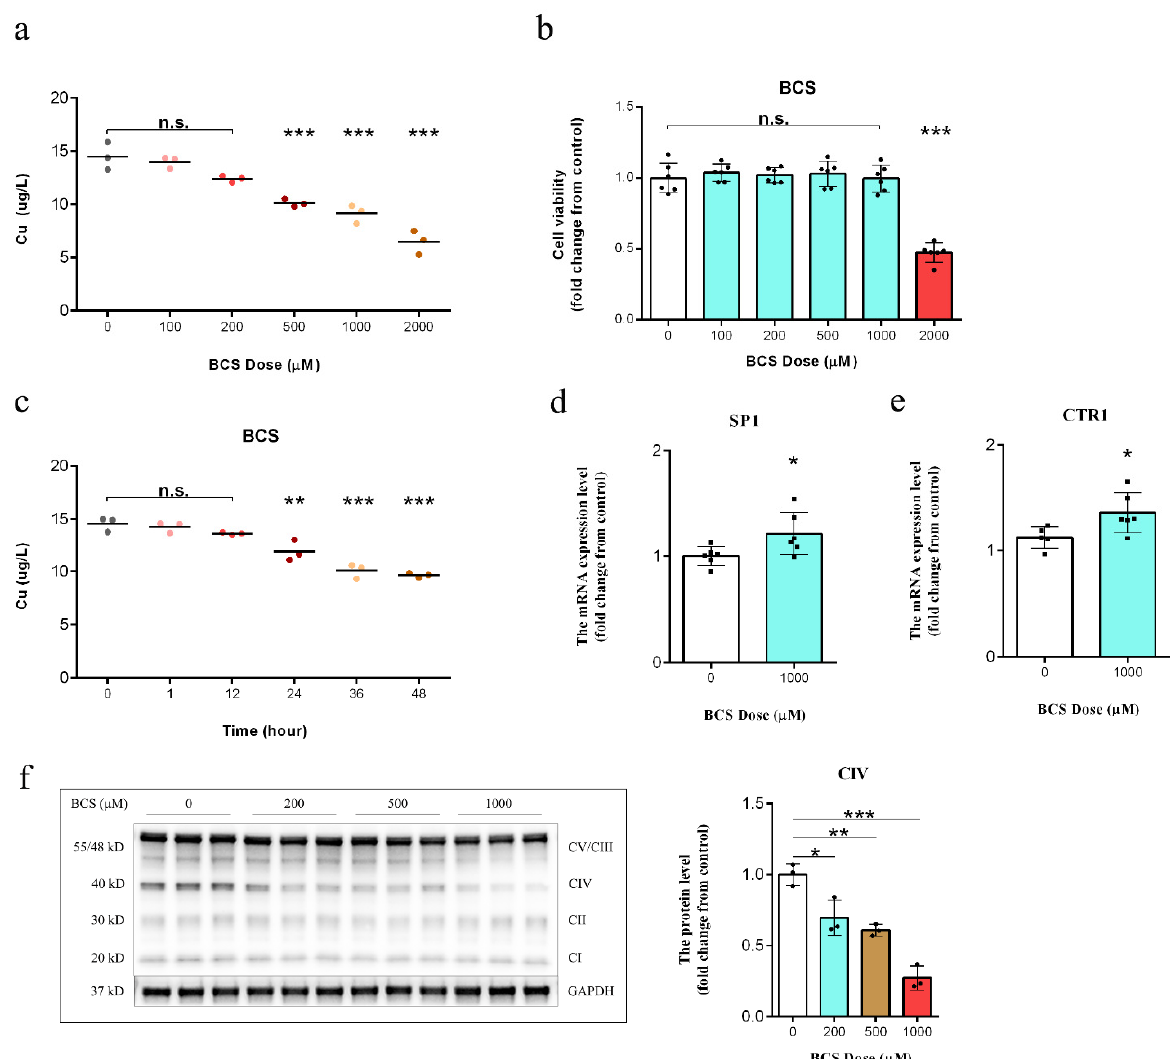
Figure 1. ( a ) Measurement of intracellular copper levels in dermal papilla cells (DPCs) after 72 h